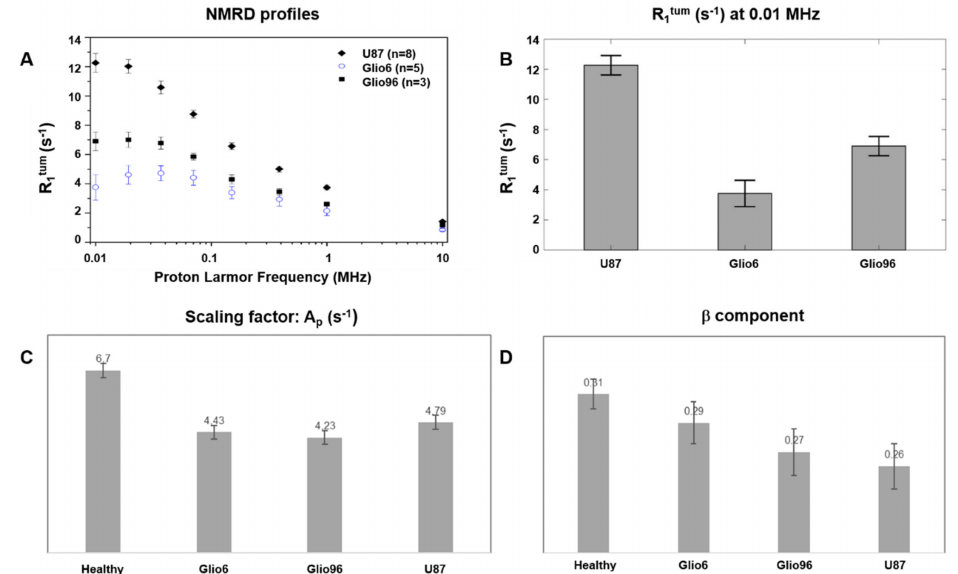
Figure 2. Analysis of relaxometric data of glioma tissue after signal muscle substraction. ( A ): NMRD profiles of glioma tissues showing a more marked discrimination between Glio models (invasion) and U87 (proliferation) at very low fields (Error bars report the standard error), and ( B ): their corresponding R 1 tum quantifications at 0.01 MHz. ( C ): scaling factor (A p ) and ( D ): component ( β ) parameters of power-law model, both confirming higher water molecular dynamics of Glio6 and Glio96 glioma tissues, compared to